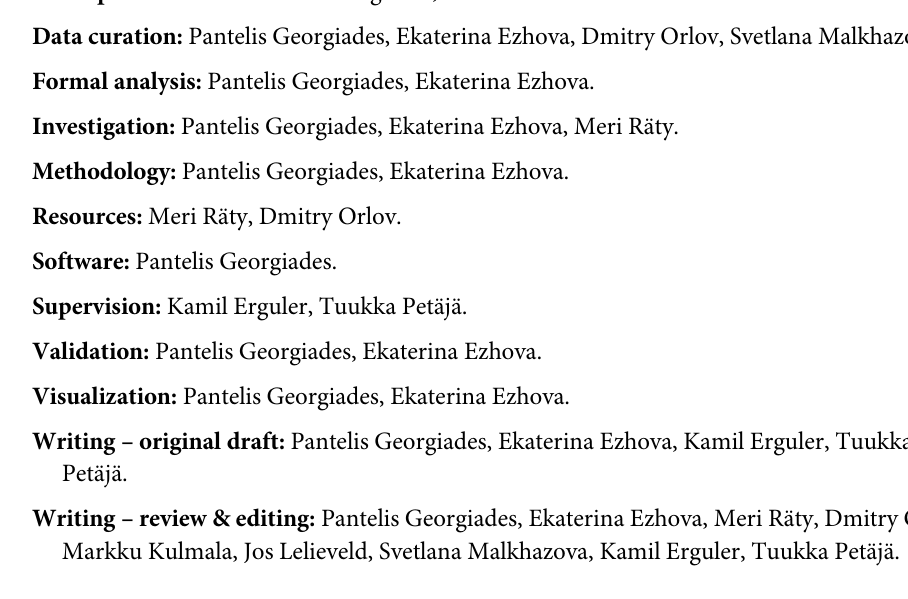
S1 Table. List of meteorological stations used in this study. S2 Table. The ERA5 variables used for performing time lagged cross correlation analysis between the tick related hospital visits and climate/land features. The minimum and maxi- mum temperature features were derived from the 2m temperature hourly variable for each day. S3 Table. The variables used from the CMIP5 models for training the machine learning model and projecting tick related borreliosis incidence until the end of the 21st century. S4 Table. The federal region clusters from where weekly tick bite related hospital visits were available. The clusters were divided into clusters with respect to the tick species and hos- pital visits dynamics found in them (Sec. 3.1). S5 Table. The federal region clusters from where yearly borreliosis cases rates were avail- able. The clusters were divided into clusters with respect to the tick species found in